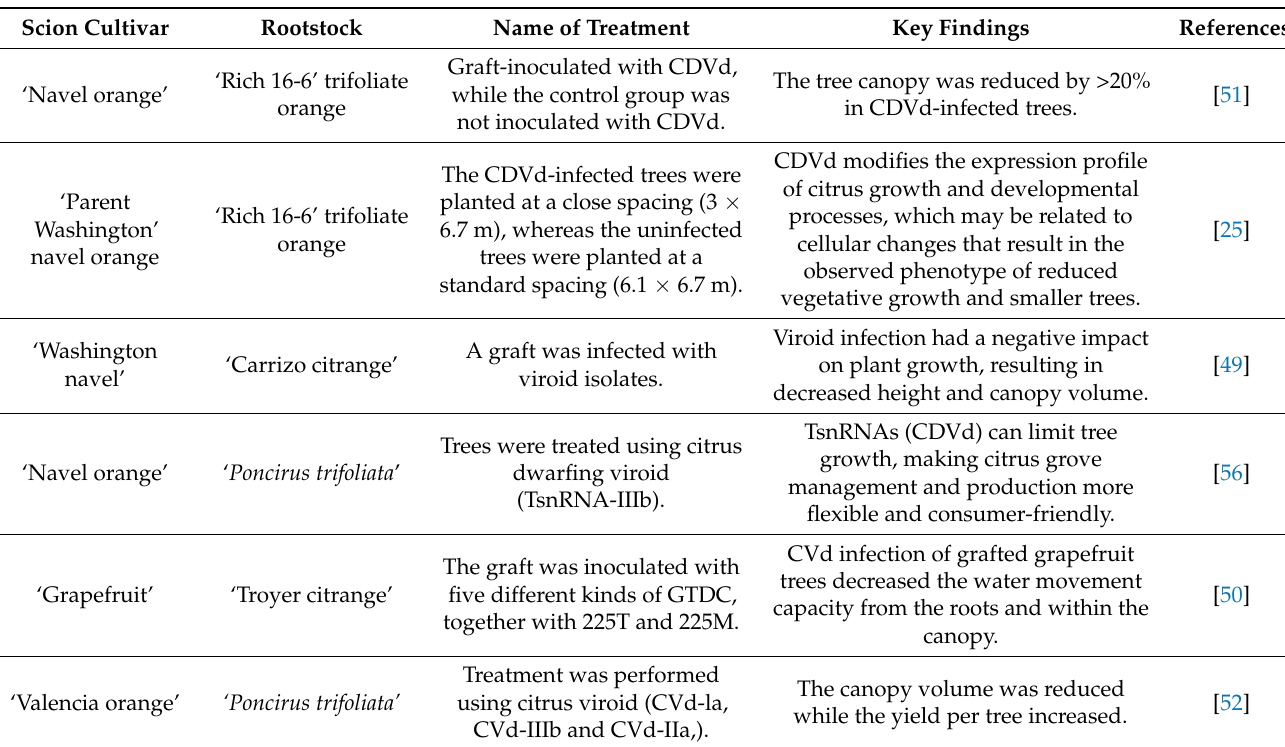
Table 2. Reduction of scion growth due to CDVd